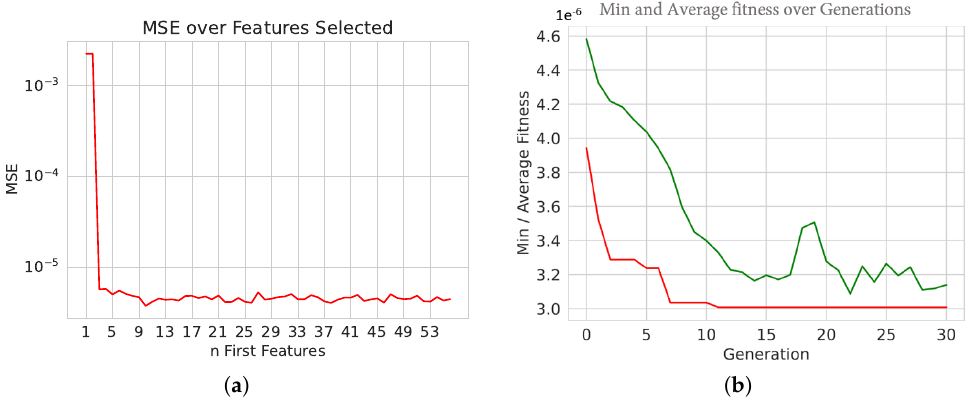
Figure 3. ( a ) Plot of the mean squared error values for the relaxation source terms regression problem. ( b ) Min/Average fitness function value over generations for the genetic